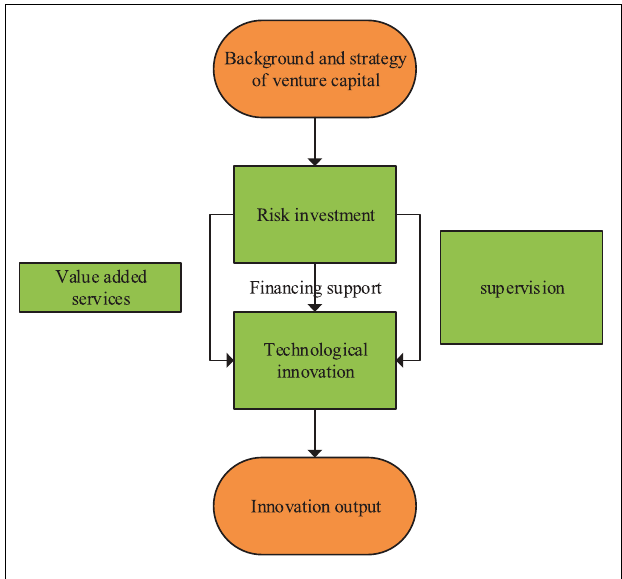
Number of Design Patent Applications (NDPA) should